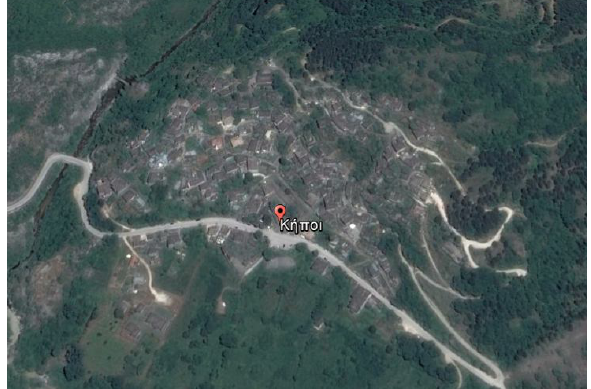
Figure 3. Satellite view of the Kipoi